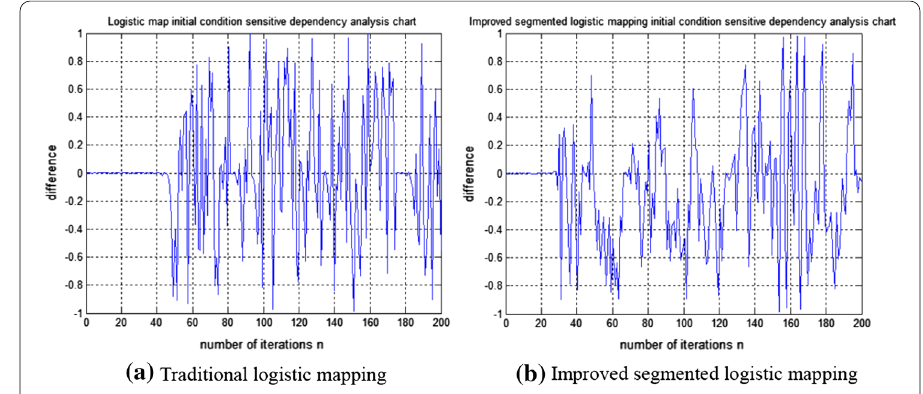
Fig. 6 Logistic mapping under small initial value